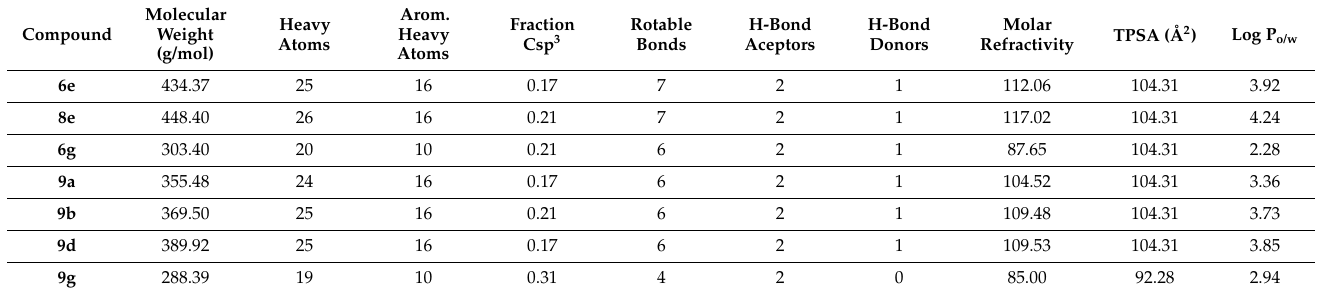
Table 3. Physicochemical and lipophilicity